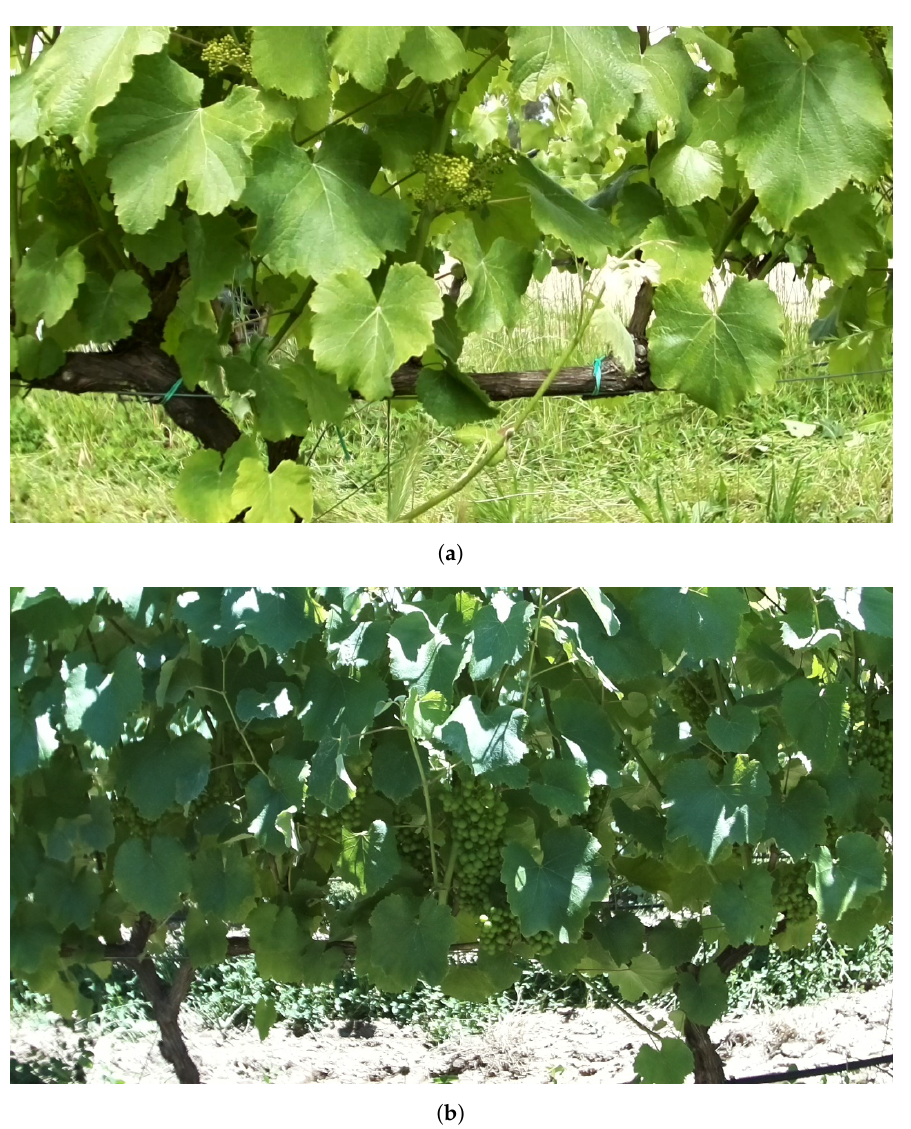
Figure 3. Two images of the proposed publicly available dataset considering ( a ) an early and ( b ) a medium grape bunch growth